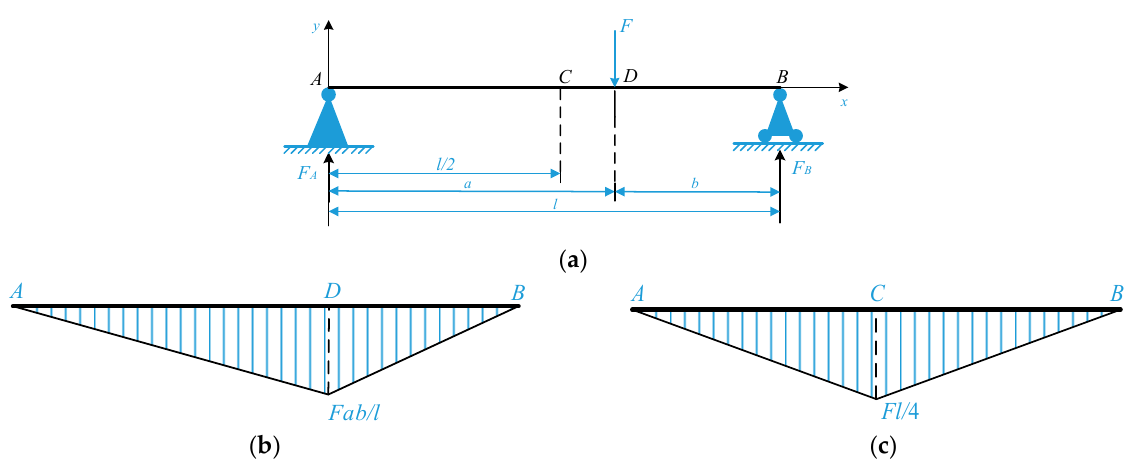
Figure 5. Schematic diagram of simply supported beam and bending moment diagram: ( a ) the simply supported beam; ( b ) the bending moment diagram; and ( c ) the bending moment diagram (when F is loaded at the midpoint of the